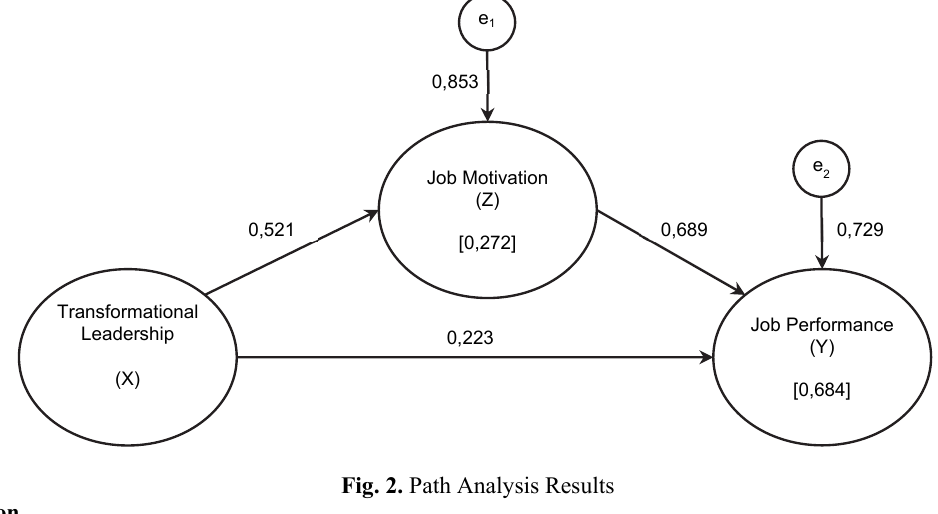
Fig. 2. Path Analysis